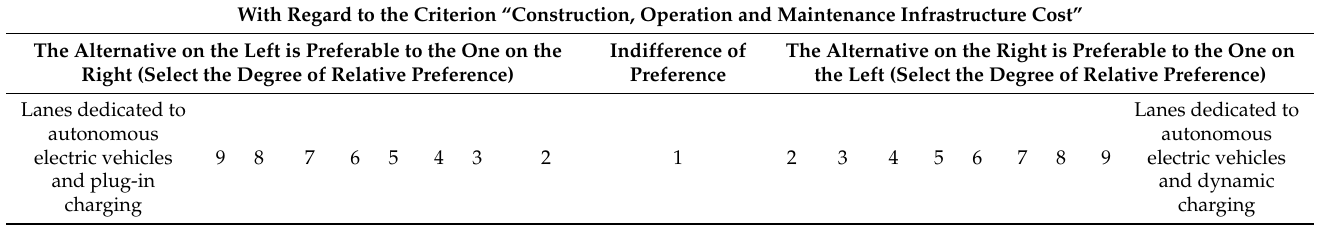
Table 8. Indicative part of alternatives’ pair-wise